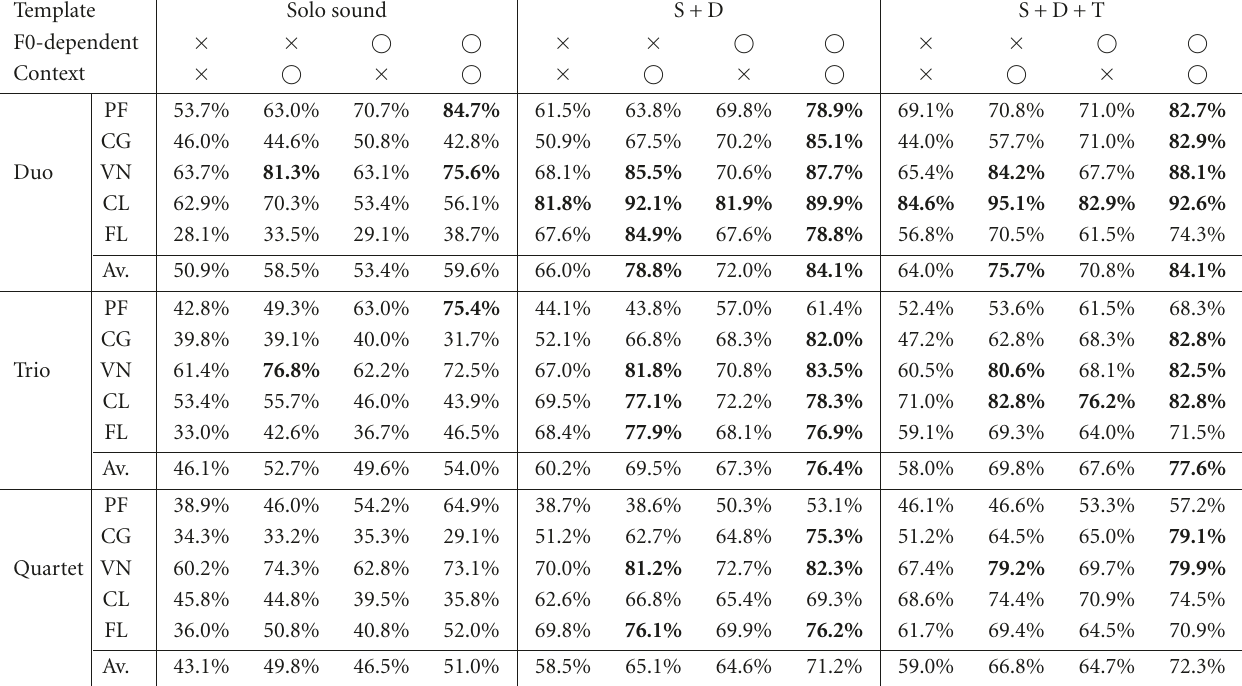
Table 6: Results of Experiment 1. (cid:8) : used, × : not used; bold font denotes recognition rates of higher than 75%.